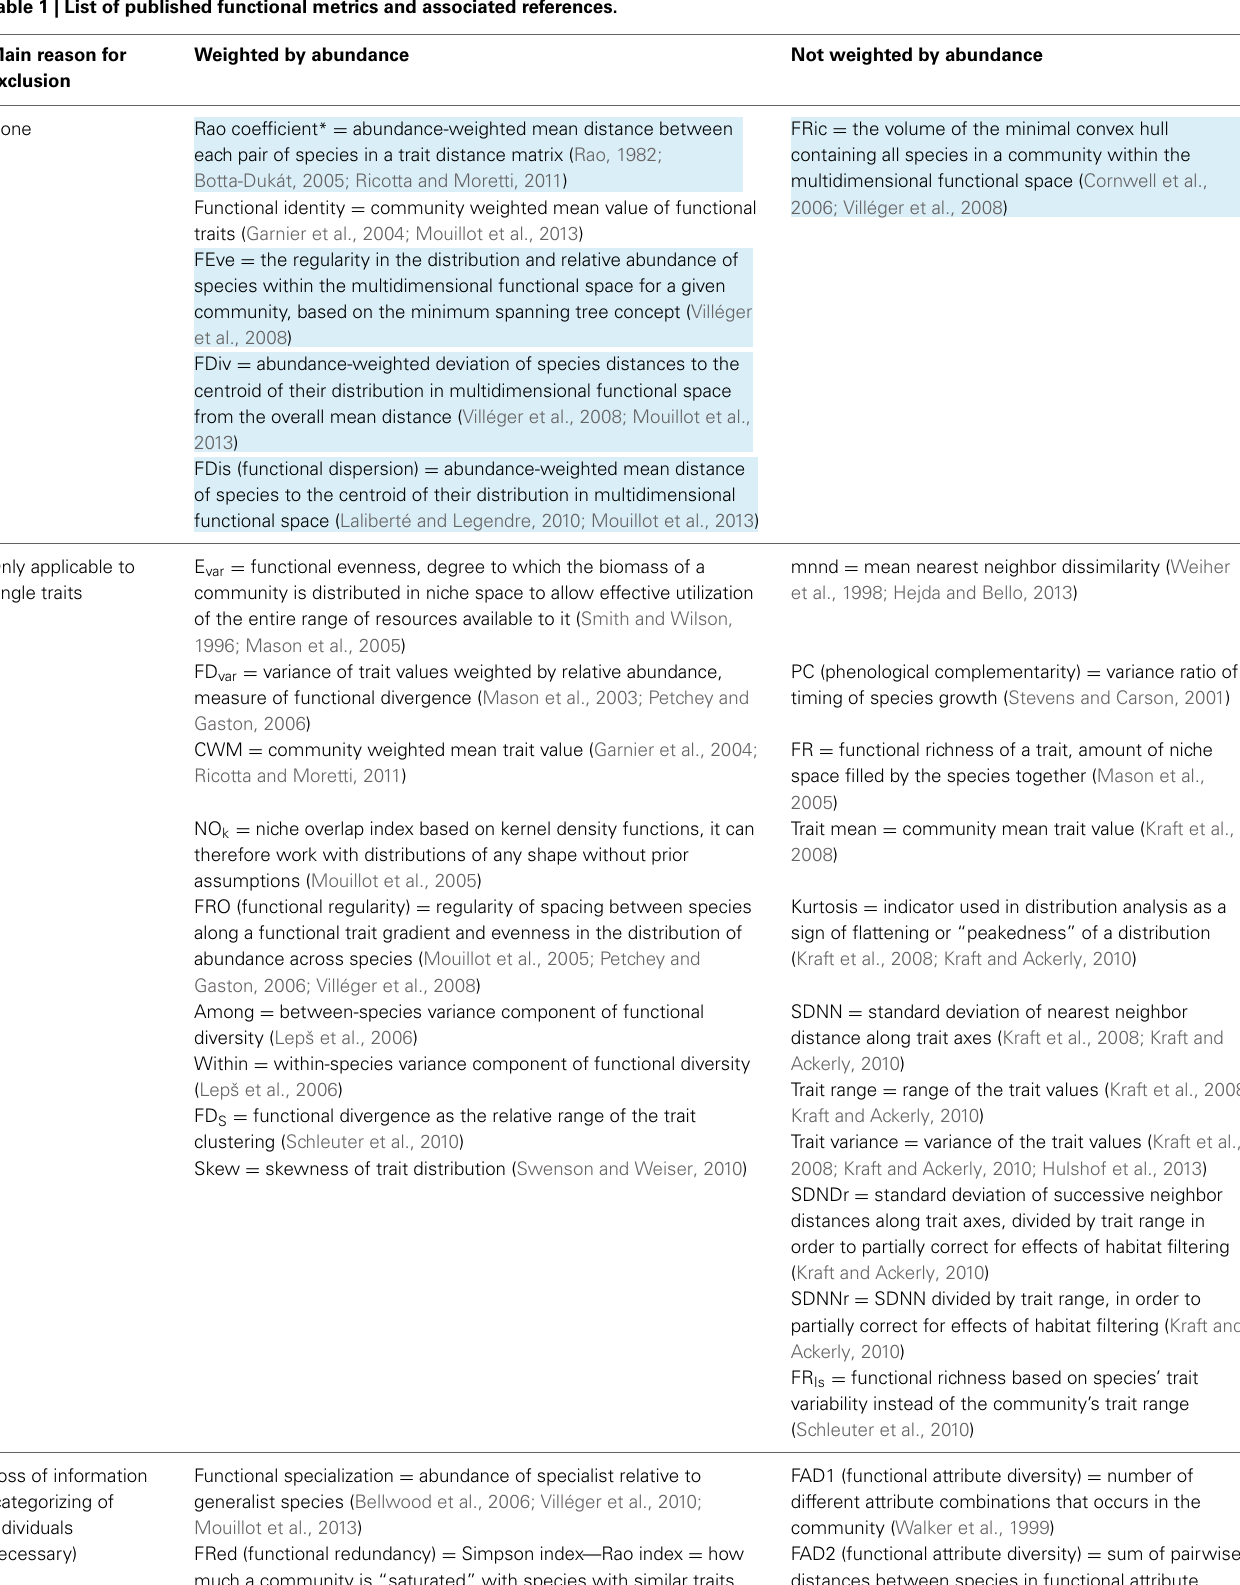
Table 1 | List of published functional metrics and associated